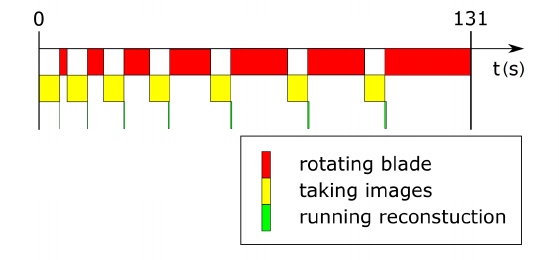
Figure 11. Time line of density reconstruction with N a = 7 projection measurements. The angles are chosen such that more projections are acquired in the direction parallel to the shock front, maximizing the information about the shock. For each projection 20 images were acquired, 10 of which were recorded with the gas jet on and the other 10 with the gas jet off, as a